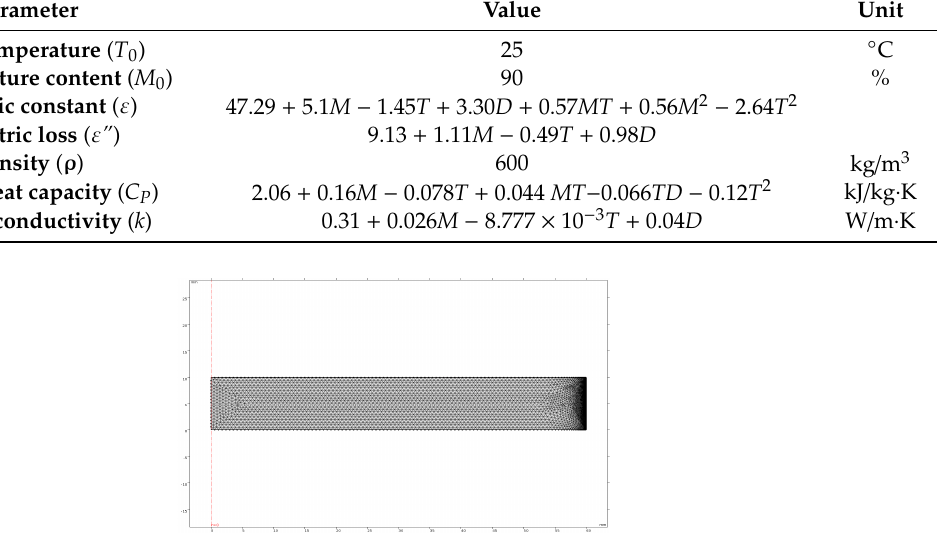
Table 7. The input parameters of berry puree used in the simulation model.